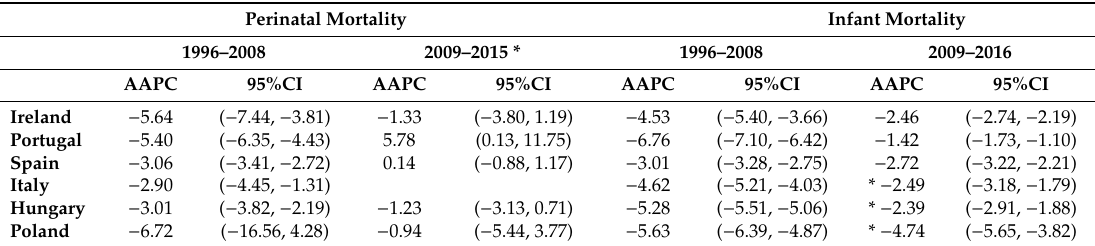
Table 2. Average Annual Percent Change (AAPC) of perinatal and infant mortality in European countries a ff ected by the economic crisis (1996–2008, 2009–2016).